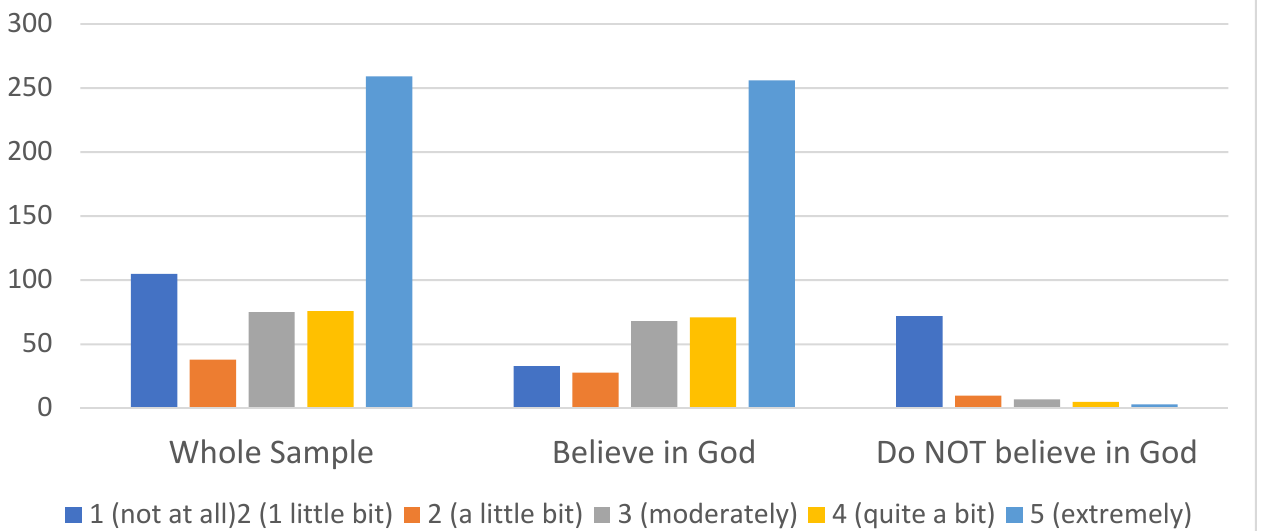
Figure 1. Open-Ended Gratitude Item: Number of Participants Who Listed God.